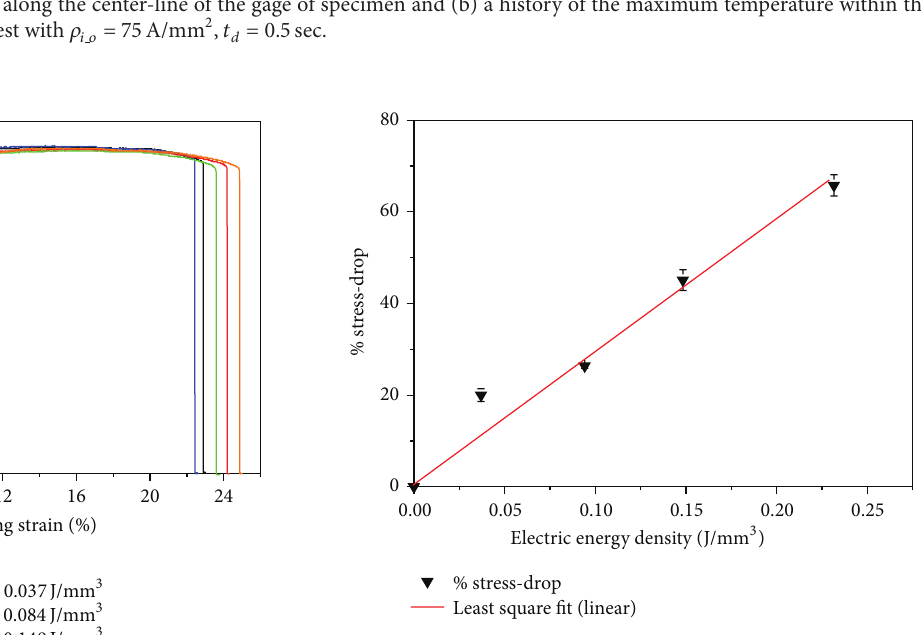
Figure 5: The percent magnitude of stress-drop as a function of the electric energy density (the least square